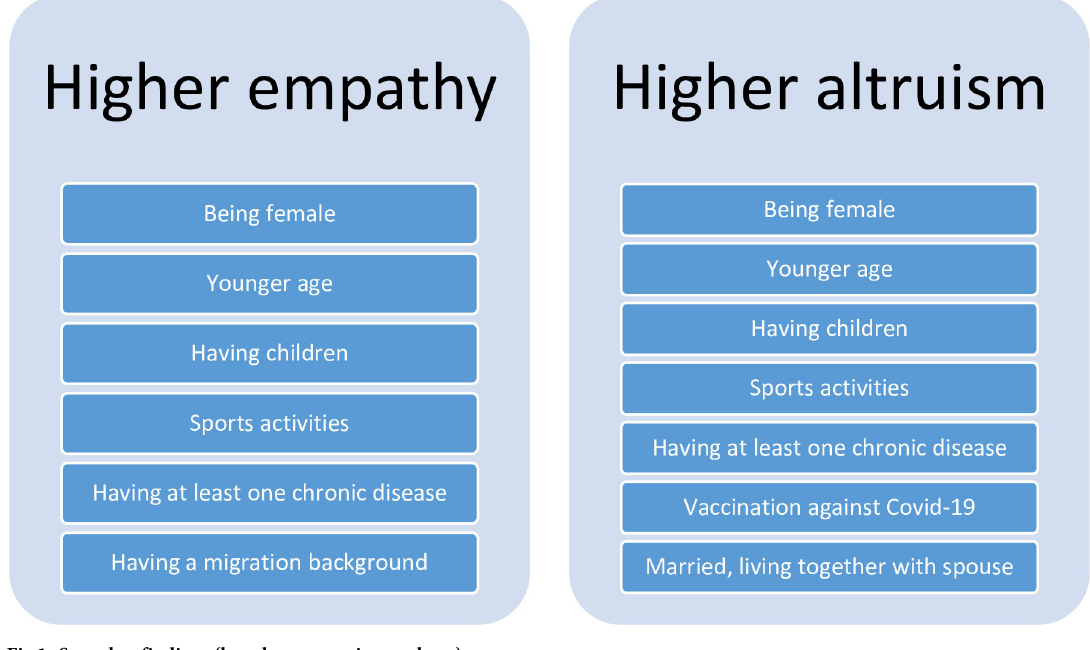
Fig 1. Some key findings (based on regression